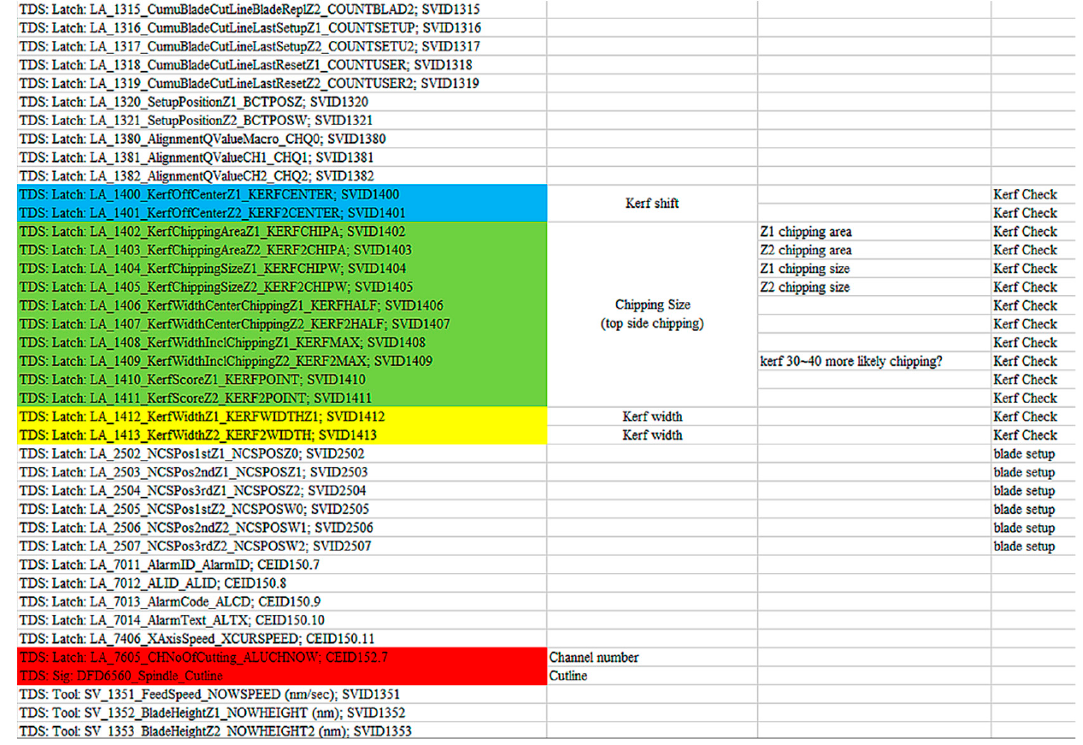
Figure 10. Parameter title and its related information.